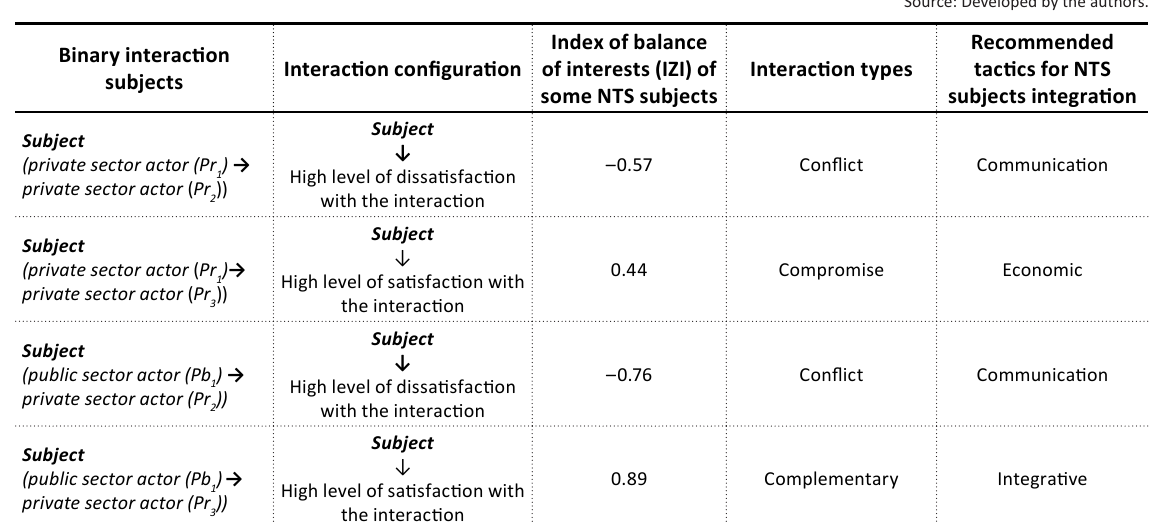
Table 2. The results of interaction of the multisubject NTS management actors